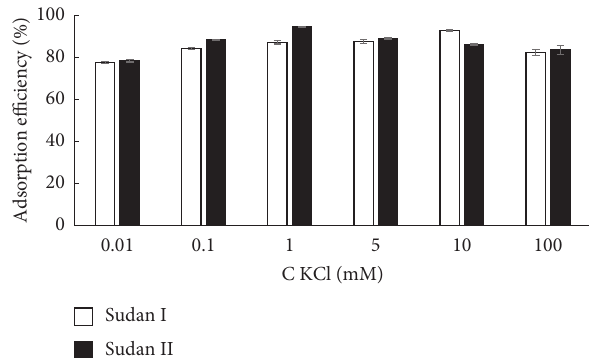
Figure 5: Effect of ionic strength on dye adsorption efficiency (0.01mM ≥ [KCl] ≥ 100mM).